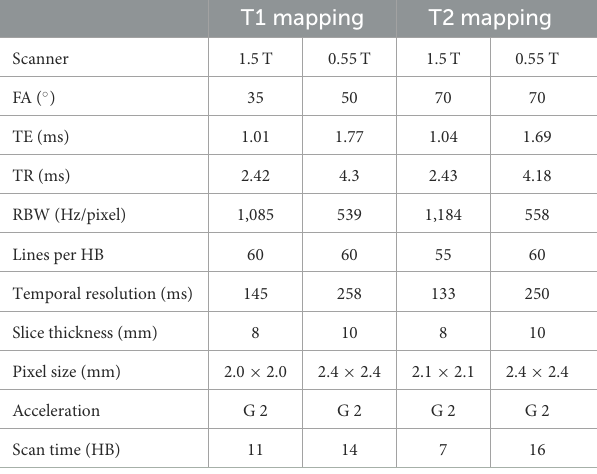
TABLE 4 Acquisition parameters for T1 and T2 mapping sequences at 0.55T in comparison to